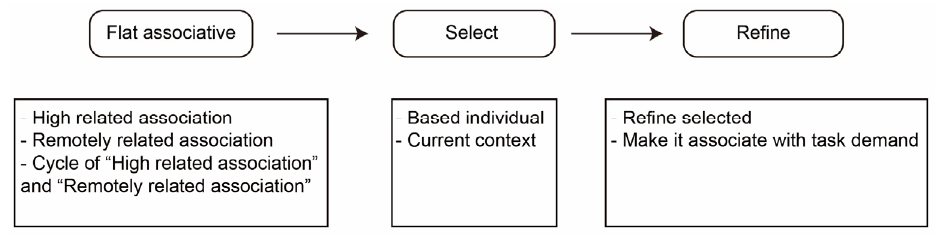
Figure 4. Gabora’s model. Figure 4. Gabora’s